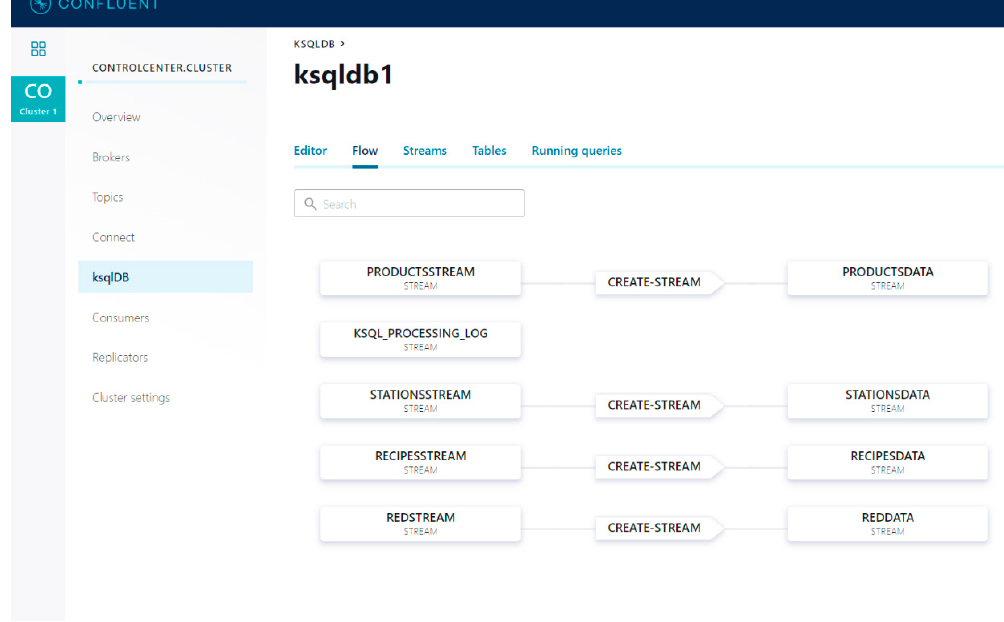
Figure 9. Overview of all created streams and their connections.